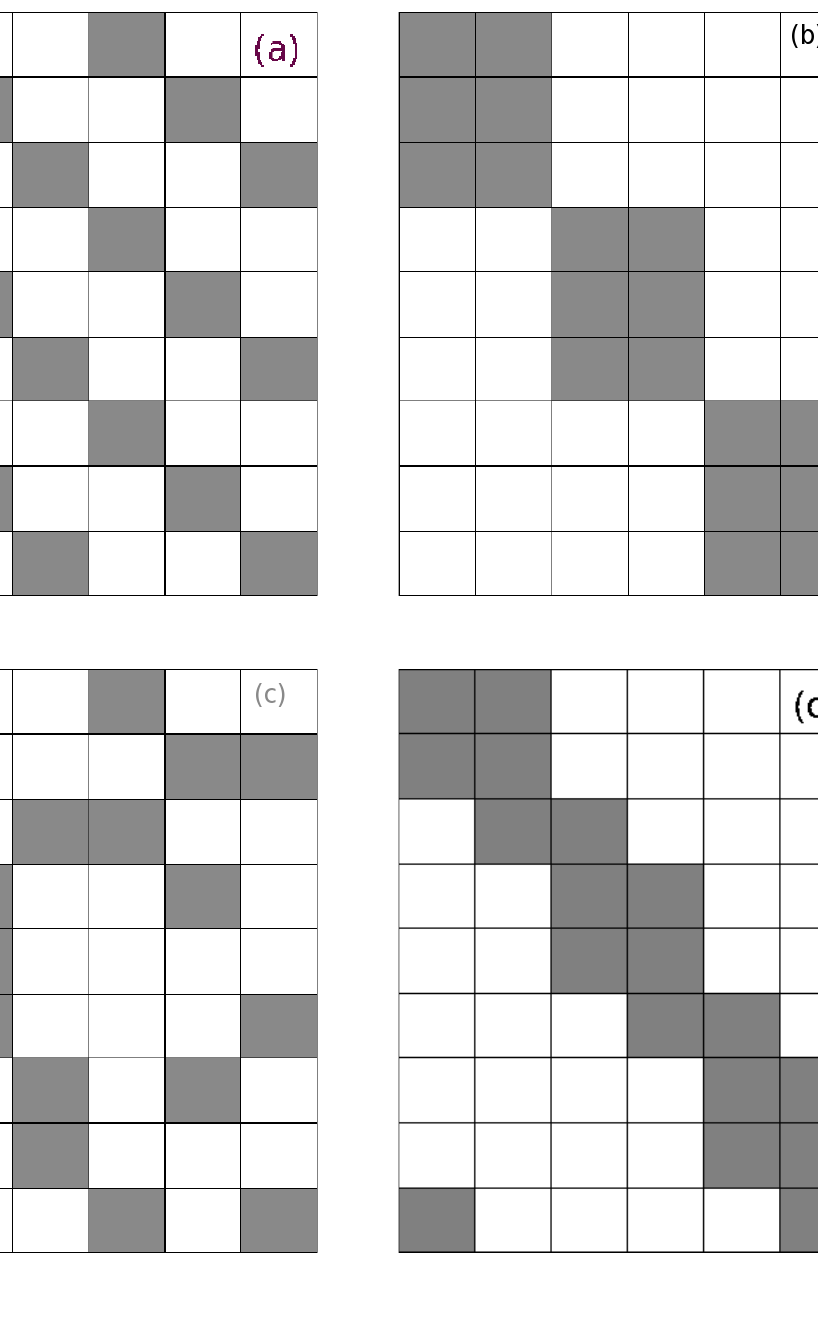
Fig. 1: Some NODF = 0 patterns. Panels (a) and (b) represent the same matrix after permutation of lines and columns; this non-chessboard tiling is a composition of three disconnected networks. Panels (c) and (d) show two connected networks that have NODF = 0 , since MT c (d) represents a gradient-like